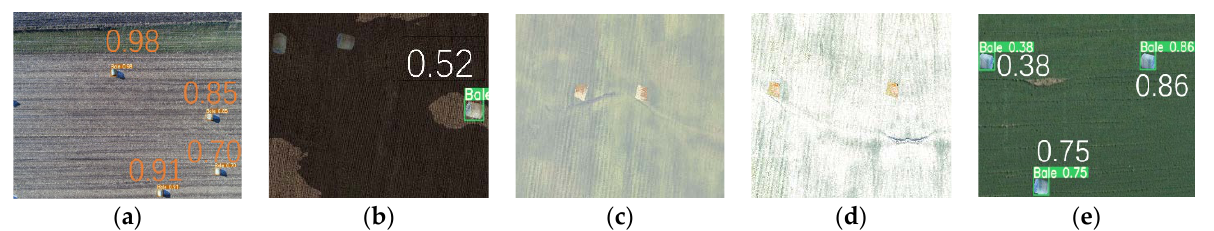
Figure 8. Example of tested bale images under multiple environmental conditions using the primary bale detection model (trained in Step 1): ( a ) initial condition with good illumination and no shadow in fall; ( b ) extended condition—early winter with shadow; ( c ) summer with haze; ( d ) winter with snow cover; ( e ) summer with good illumination conditions.